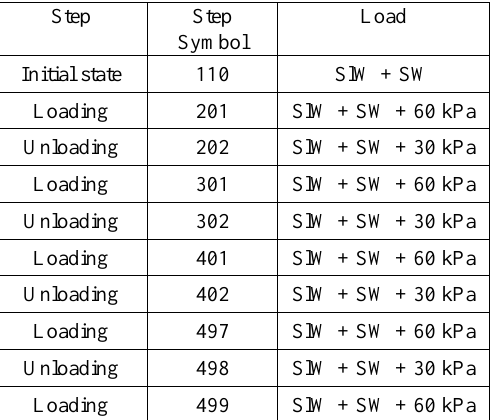
Fig. 3. Evolution of efficiency vs loading cycles (a) and slab settlement ds (b).